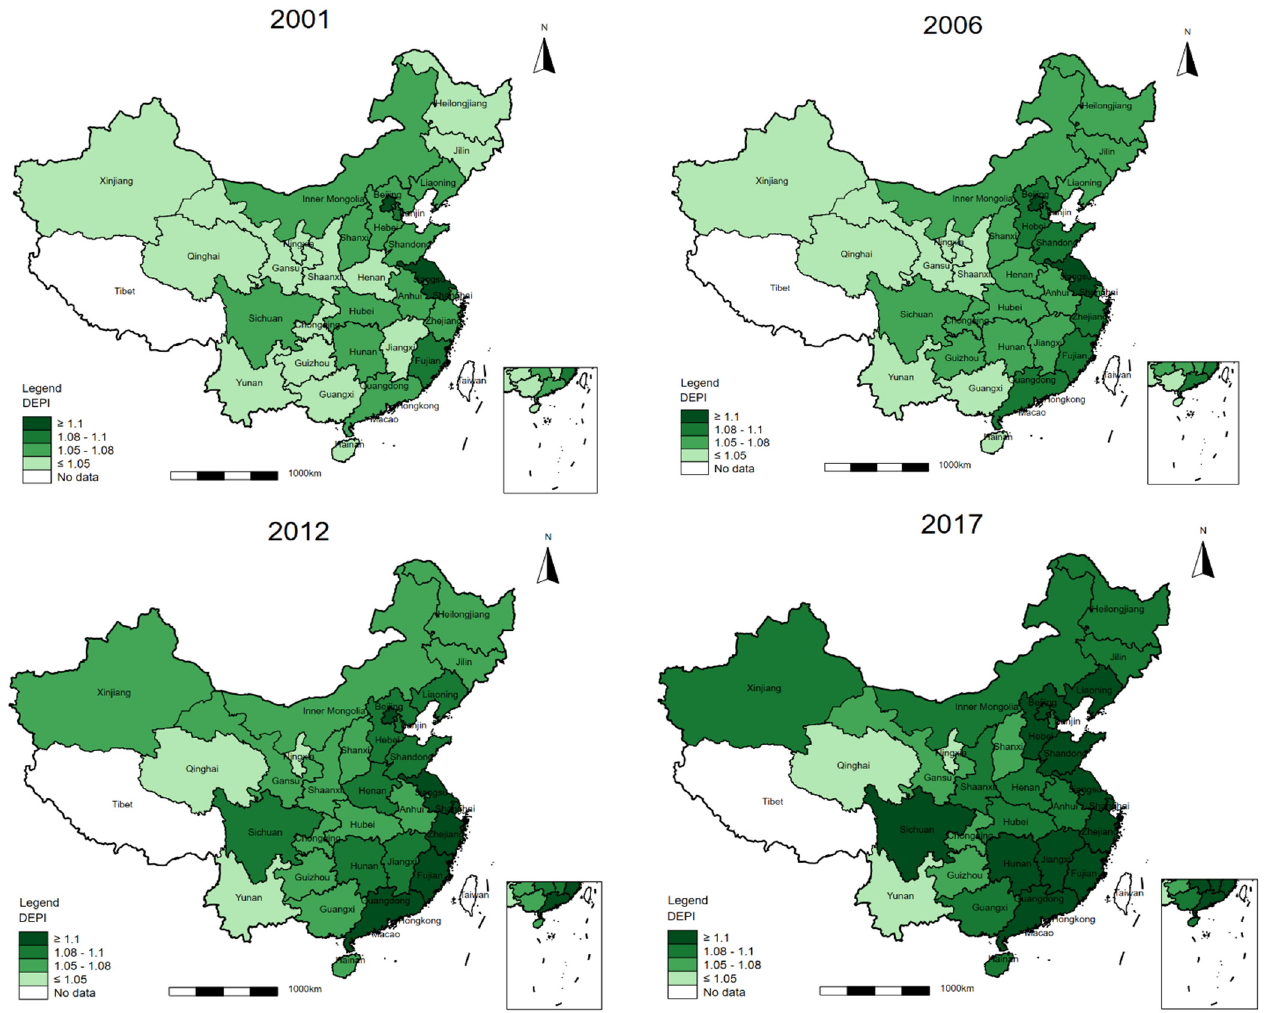
Figure 1. Spatial distribution of energy efficiency performance in 30 provinces of China.